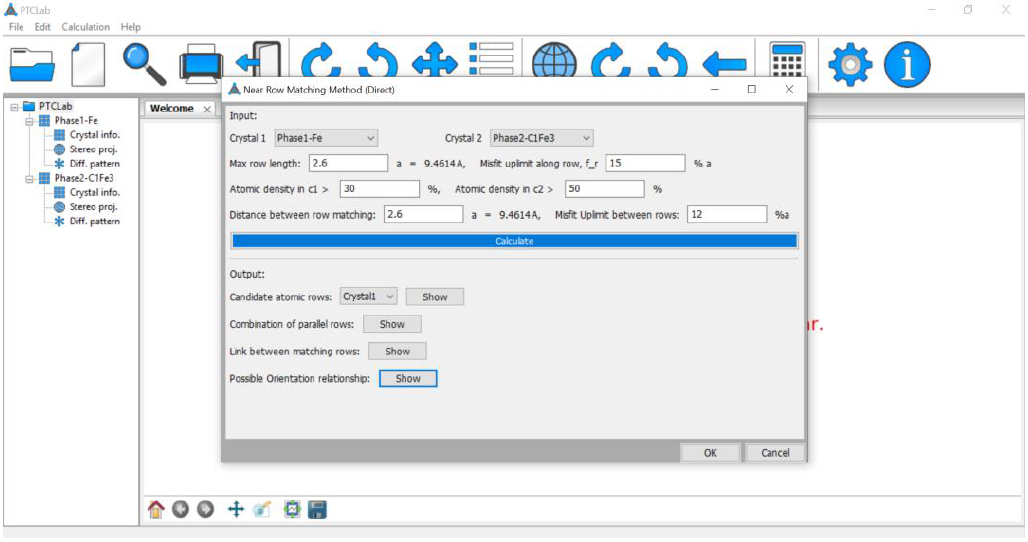
Figure 7. The interface for the near row matching method in PTCLab.